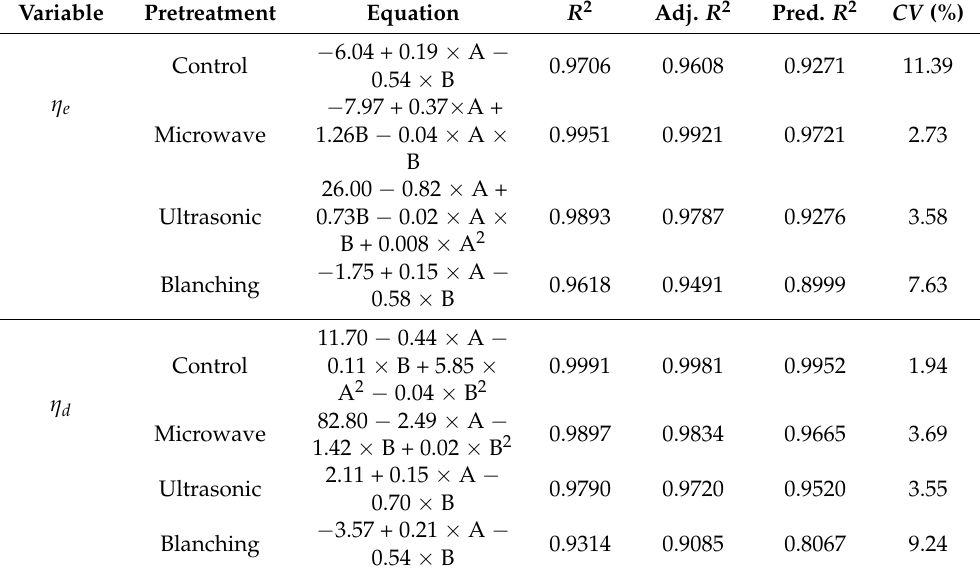
Table 5. RSM modeling of the energy and dryer efficiencies under an HCIR dryer with different